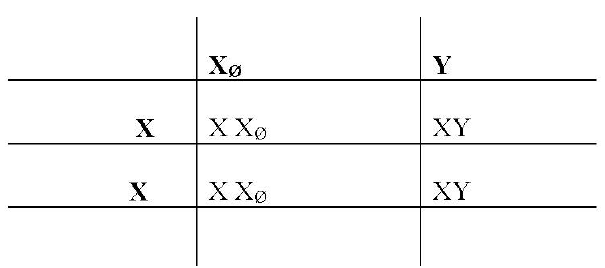
Figure 6. X-linked paternal recessive: There is 100% chance that all females will be